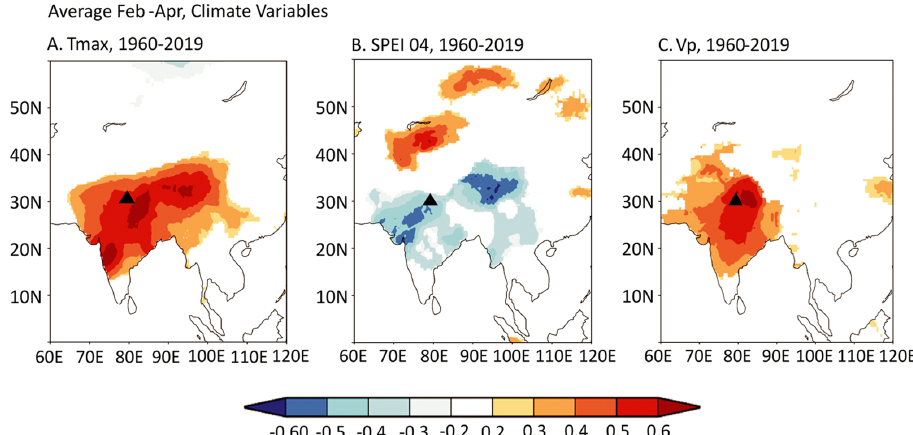
Figure 8. Spatial correlations of δ 18 O TRC with the climate variables Tmax (D), SPEI 04 (E), and vapour pressure (F); areas with p >0.05 are masked; Black triangles in ( A – C ) represent the location of the study site.